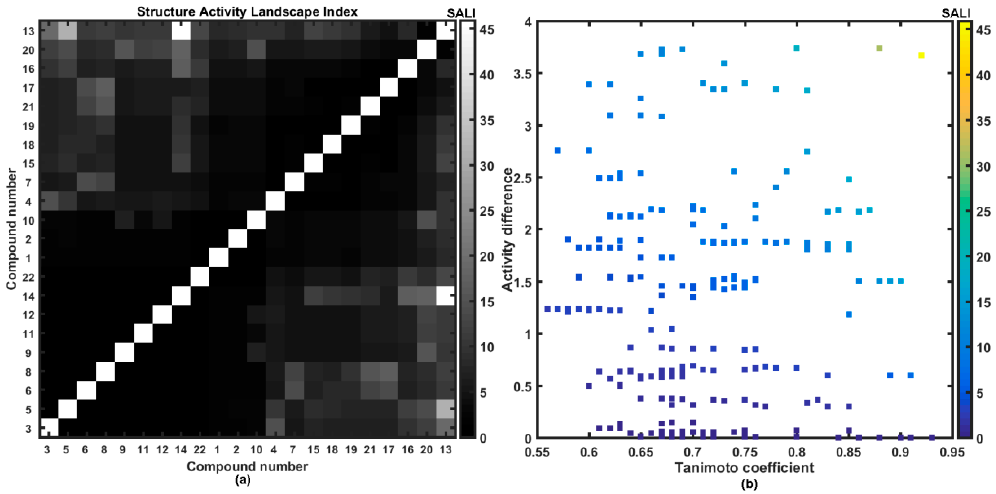
Figure 4. Grayscaled SALI plot with compounds ordered with increasing ATCC 29213 activities ( a ) and neighboring plot ( b ) for 1 – 22 carboxamides.